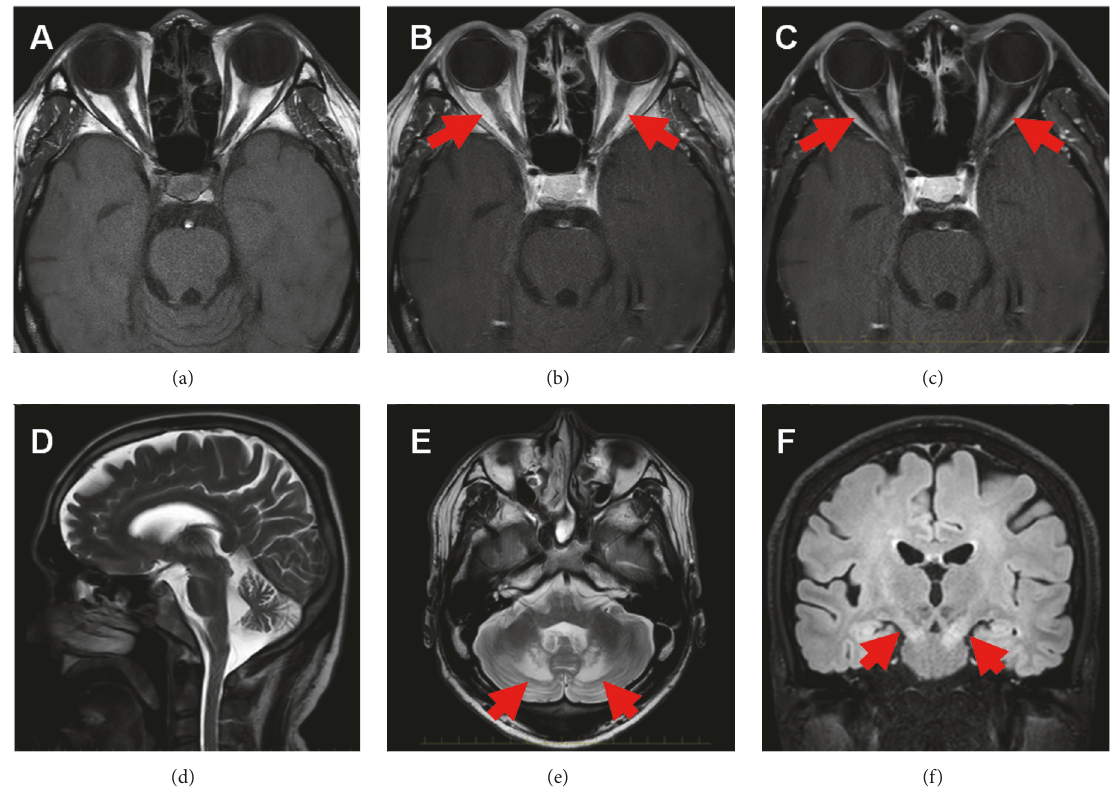
Figure 2: Brain magnetic resonance imaging revealed the following: bilateral swelling of optic nerves on T1-weighted images (a) with enhancement (arrows) on gadolinium-enhanced T1-weighted (b) and T1 weighted fat-suppressed images (c), enlarged fourth ventricle and cerebellar atrophy (d), and hyperintensities in the bilateral dentate nuclei (arrows, (e)) on T2-weighted images; FLAIR images demonstrated hyperintensities in the bilateral dentate nuclei and pyramidal tract (arrows,